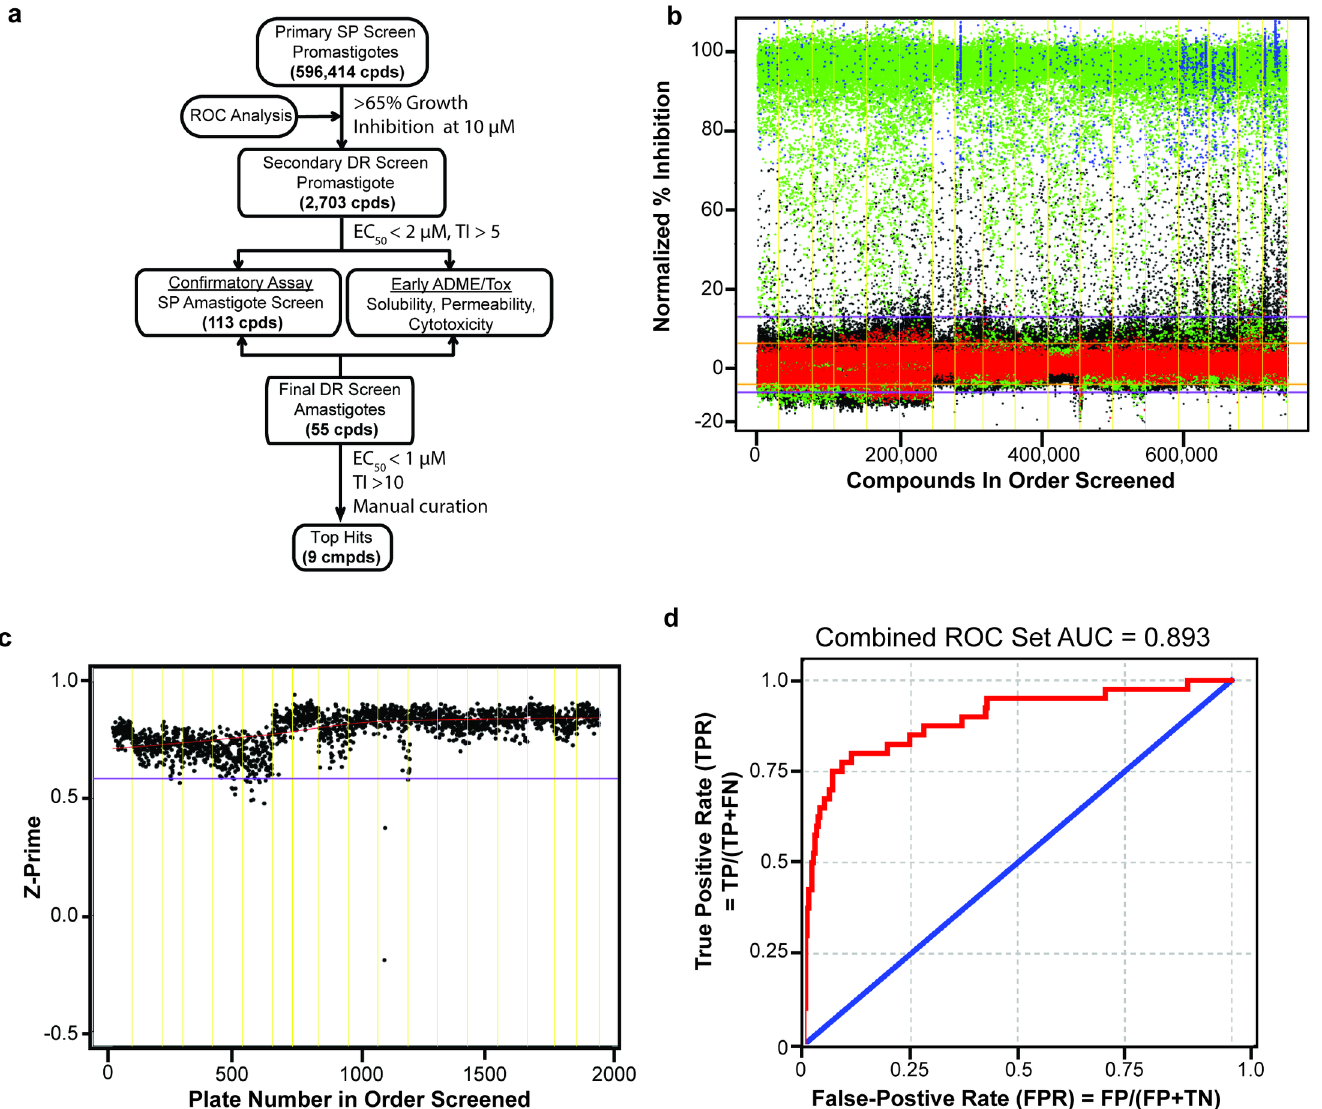
Fig 1. Screening flow chart and high throughput primary screen of promastigotes. a. Schematic of the high-throughputscreeningworkflow. SP refers to single point, or single concentration, and DR representsdose-response. The cutoff value of 65% inhibitionin the first step was chosen based in ROC analysis, the cutoff of 2 μ M and TI > 5 in step 2 was somewhat arbitrary but produceda reasonable numberof hits for subsequent analysis, and the cutoff of 1 μ M and TI > 10 for the final step is consistent with recommendations for lead identification for leishmaniasis [12]. b. Scatter plot of primary screen data shown as normalizedpercent growth inhibition. Each dot represents the activity of one compound.Negativecontrols (DMSO treated) are in red, positive controls (pentamidinetreated) are in green, test compoundsare in blue (hits) or black (non-hits). The orangeand purple horizontal lines indicatethe 95% and 99% quantiles of activity respectively. c. Primary screen qualitycontrol: Z-prime value per assay plate screened, lower outlier bound (in purple), yellow lines separatescreen runs. d. Receiveroperatingcharacteristic (ROC) curve (red); the combinedROC set AUC is 0.893. The blue line represents an AUC of 0.5 that is indicativeof an assay with random results. TP is true positive, FP is false positive, FN is false negative,and TN is true